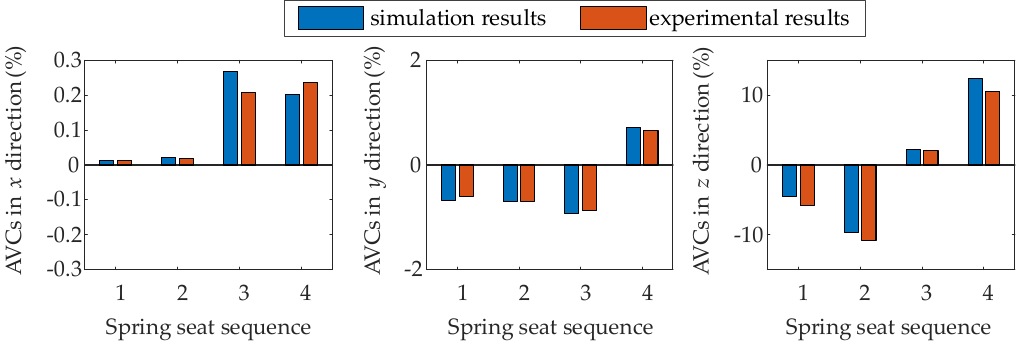
Figure 10. The amplitude variation coefficients (AVCs) of each spring seat in the x , y , and z directions under spring failure kind 1, including the simulation results and experimental results.